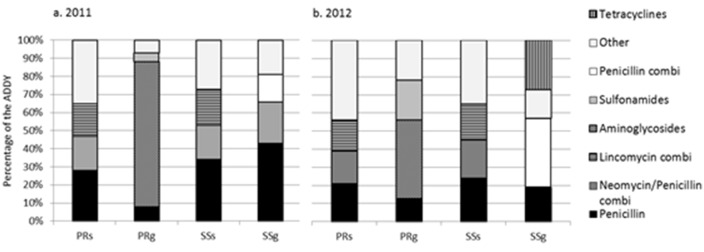
The distribution of the three most frequently used classes of active substances, and the rest summarized in the category “other”, presented as percentages of the total estimated animal used daily dose of antibiotics per year (AUDD/Y) in 2011 (a) and 2012 (b) per subtype of small ruminant farms in the Netherlands (PRs: professional sheep farms (≥32 sheep), PRg: professional goat farms (≥32 goats), SSs: small scale sheep farms (<32 sheep), SSg: small scale goat farms (<32 goats).The category “other” can, besides the 7 classes already described in the legend of the figure, also contain TMPS, Polymixins, Macrolides, Lincomycins, Fluoroquinolones, Fenicoles, Cephalosporins.